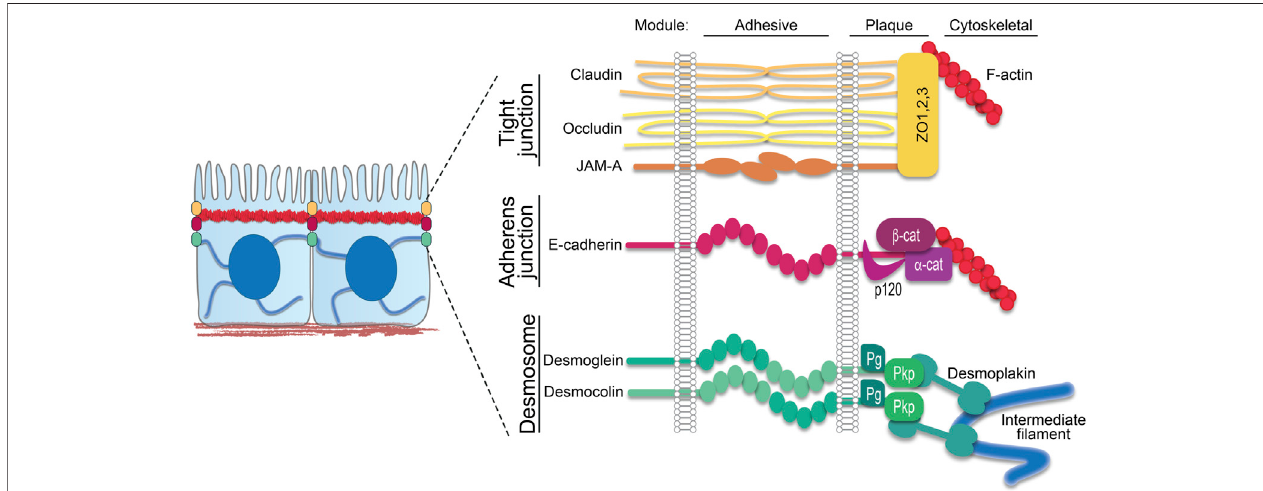
FIGURE 1 | Epithelial junction components. In simple epithelia, the apical junctional complex comprises apical tight junctions followed by adherens junctions, both anchored to the cortical actin ring, and then desmosomes, which anchor the intermediate fi lament network to the plasma membrane. Schematic shows these three major intercellular junctions associated with cytoskeletal fi laments. Transmembrane components span the intercellular space as part of the adhesive core. On the intracellularside,thesetransmembrane componentsinteract withplaque proteins thatinturnanchor their respectivecytoskeletal fi laments.ZO, zonula occludens;